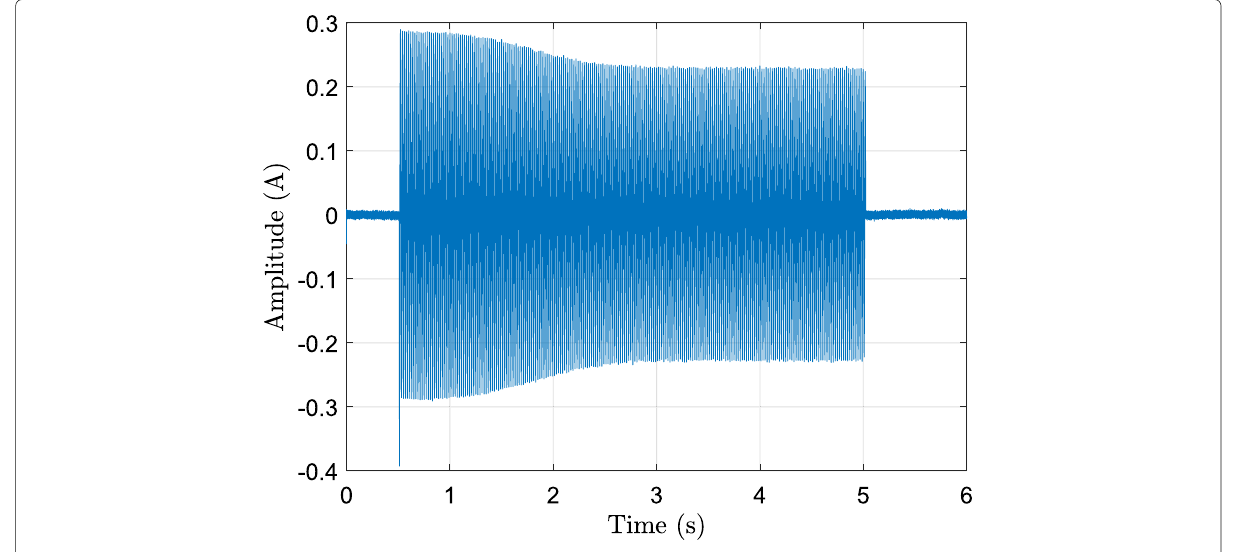
Fig. 13 Turn-on transient current of a fan from the COOLL